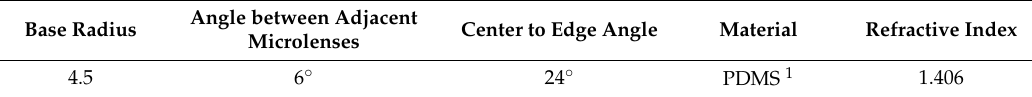
Table 1. Compound eye structure design parameters.